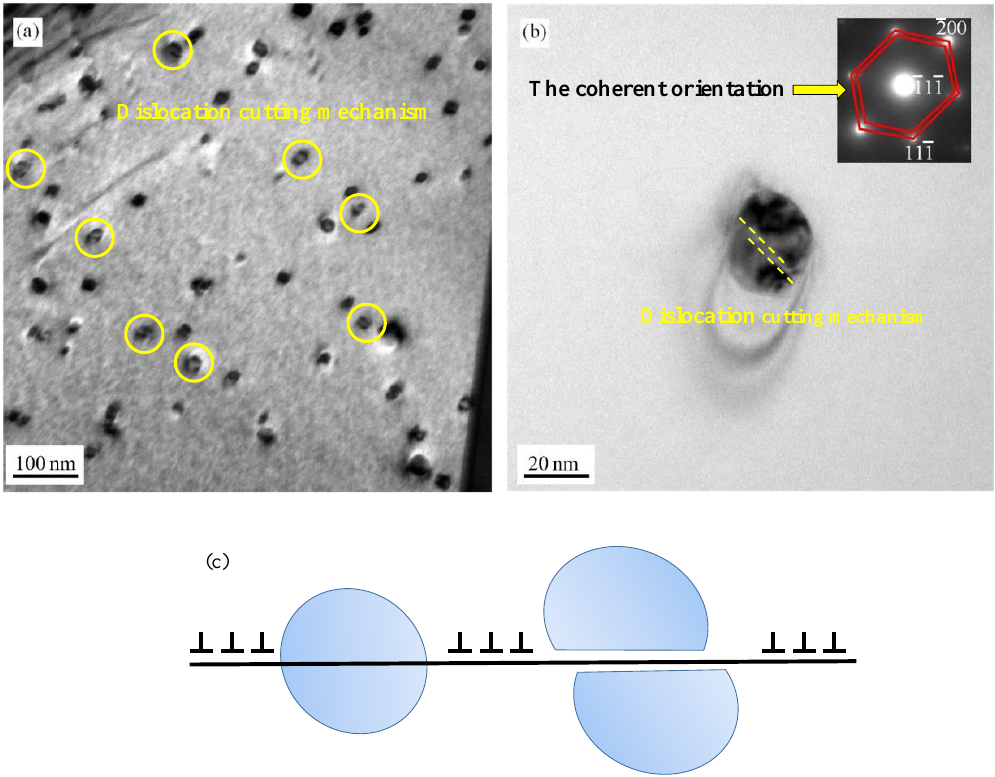
Figure 5. TEM analysis of the precipitates in specimens aged at 650 °C for 2 h. ( a ) The bright field image and energy spectrometer detection of the particles, ( b ) diffraction patterns of the particles, ( c ) the schematic diagram of dislocation cutting mechanism.